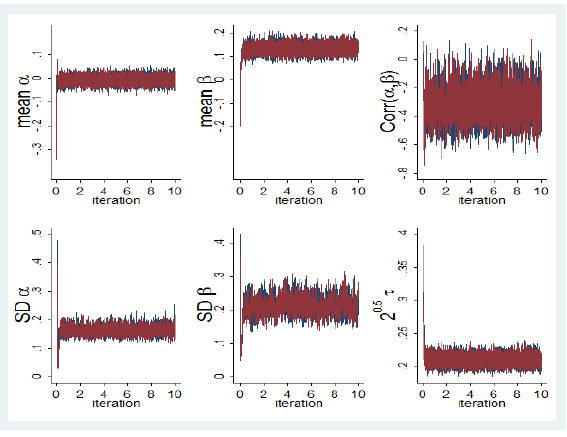
Figure 1. History of draws from the posterior distribution of parameters per 10 3 iterations to assess